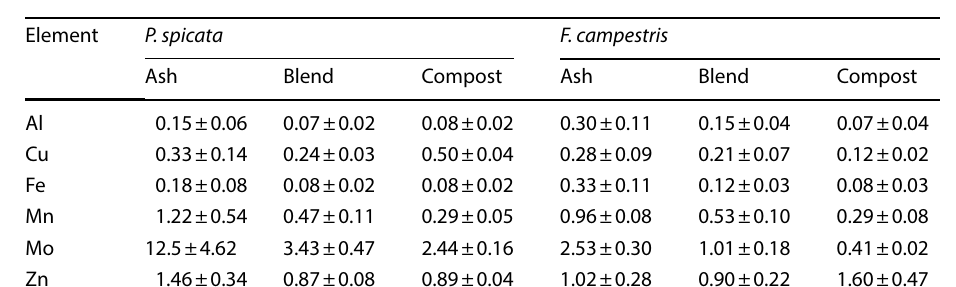
Values are means ± standard error of the mean ( n